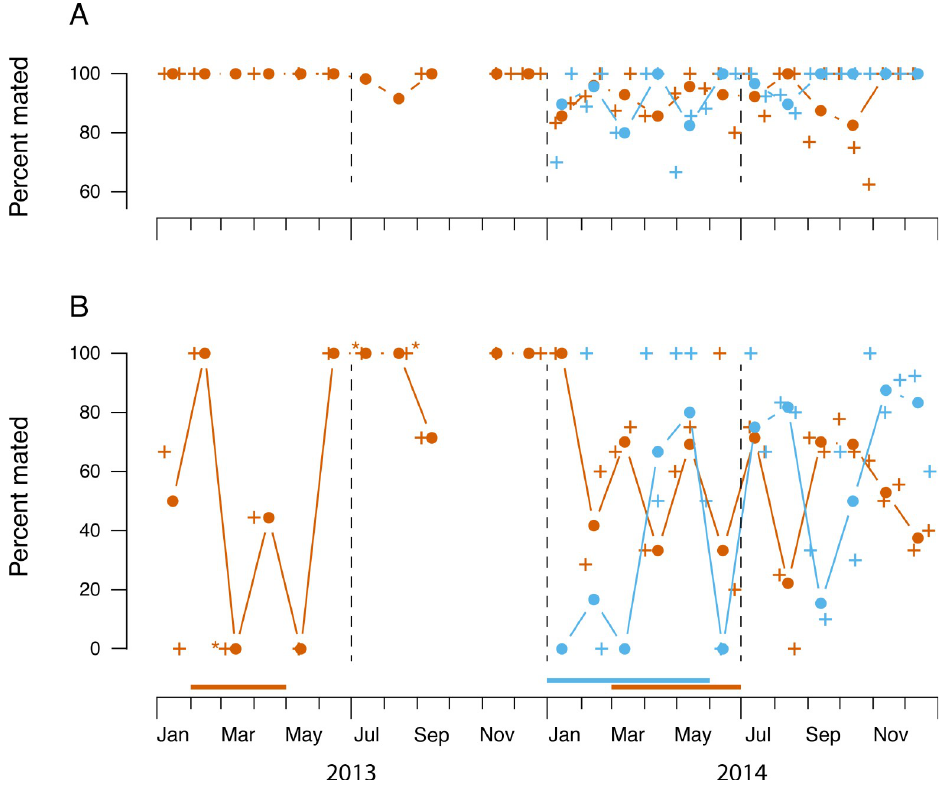
Fig 4. Mating frequencies among gravid (A) and undeveloped (B) Philornis females. Lowland (orange), highland (blue). Crosses are raw proportions of n = 7–19 females (or � n = 2). Filled circles with lines are pooled proportions plotted by midmonth, estimated with binomial regression. Horizontal bars above calendar scale indicate breeding seasons of known hosts.